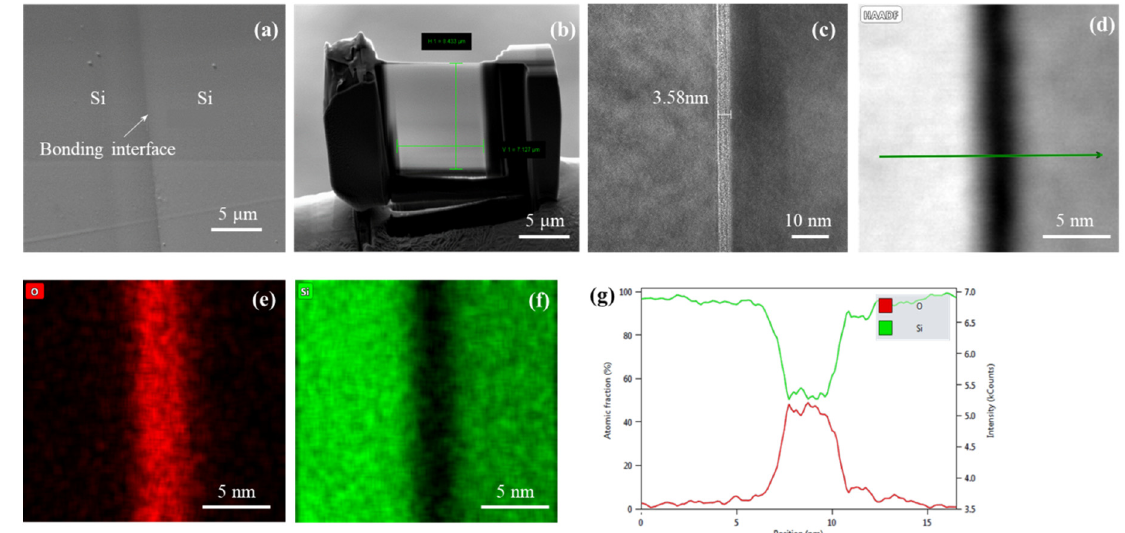
Figure 9. Microstructure and composition of Si/Si bonding interface. ( a ) SEM image. ( b ) TEM sample fabricated by FIB. ( c ) HRTEM image. ( d ) STEM image at HADDF mode and the line scan direction. ( e ) and ( f ) are the EDX mappings of O and Si elements, respectively. ( g ) Atomic ratio of silicon and oxygen at the bonding interface.